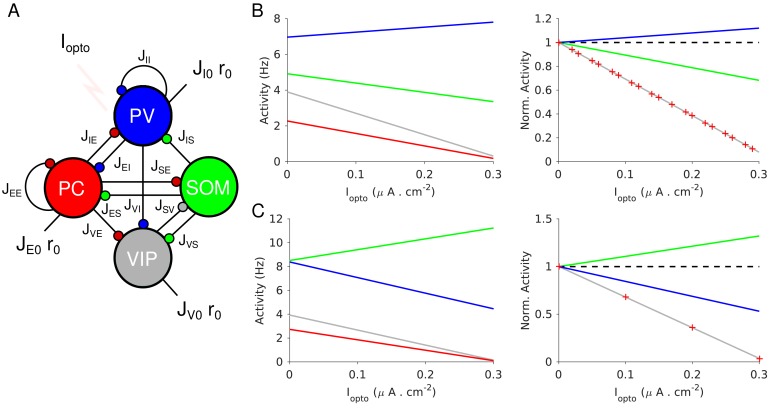
Population activities vs. Iopto in Model 1 in the large N, K limit.(A) The network is composed of four populations representing PCs, PV, SOM and VIP neurons. The connectivity is as in Pfeffer et al. (2013). (B) Parameters as in Table 4. The activity of PV cells increases with Iopto while for the three other populations it decreases. (C) Parameters as in Table 5. The activity of SOM neurons increases with Iopto while for the three other populations it decreases. Right panels in B and C: the activities are normalized to baseline.